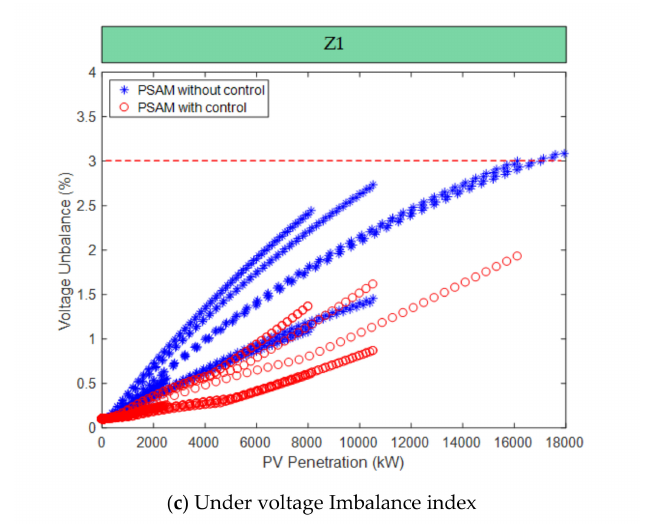
Figure 11. Results of PVHC enhancement.